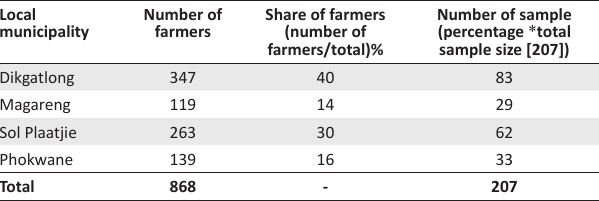
TABLE 1: Number of farmers who received assistance from the government and sampling procedure. Local